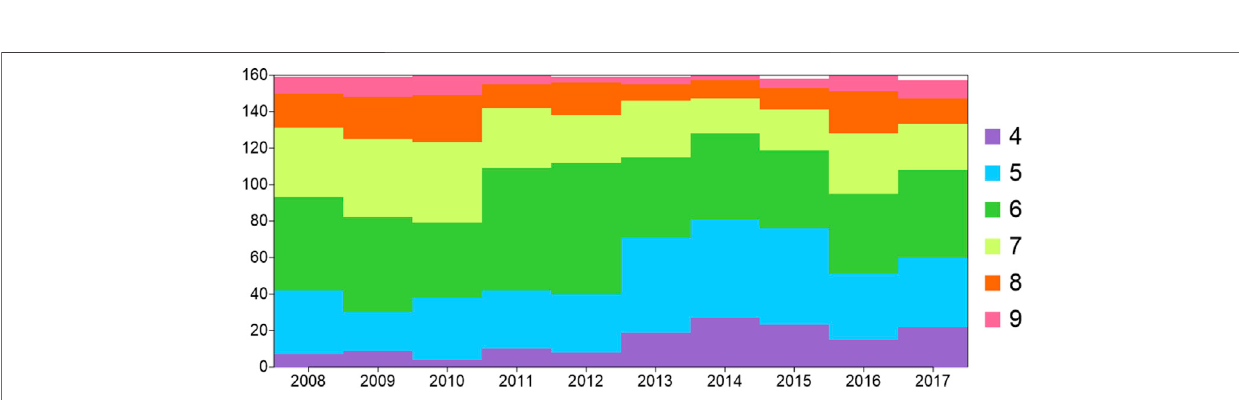
Frontiers in Physics |